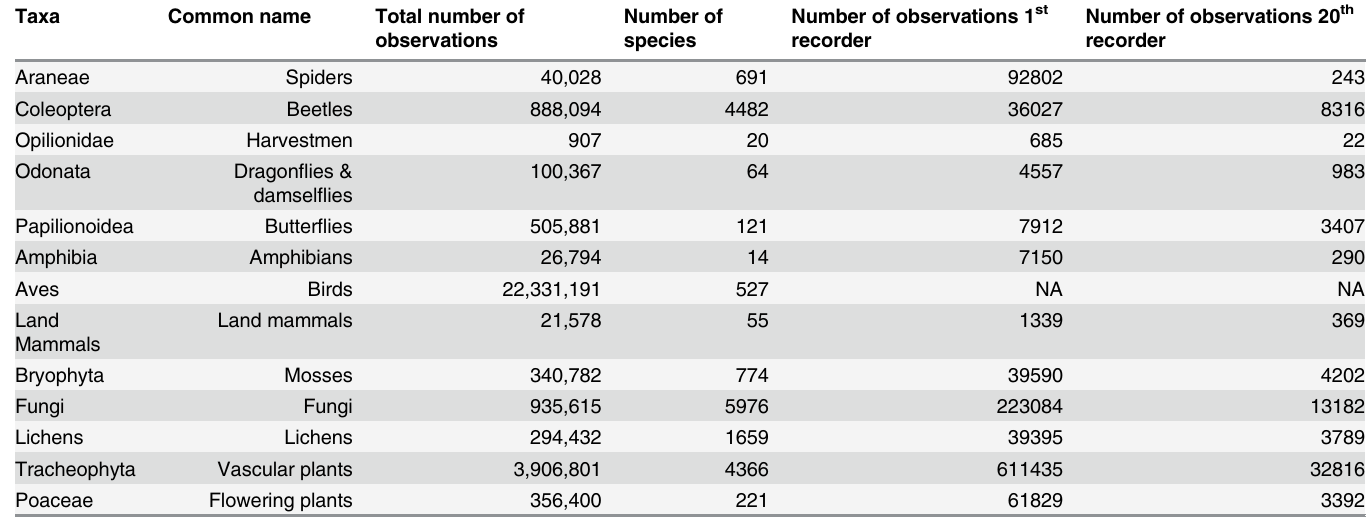
Table 1. The total number of observations across Sweden for each of the 13 taxonomic groups studied for the period 2000 – 14, the number of spe- cies in each taxonomic group, and the number of observations contributed by the 1 st recorder and the 20 th recorder (ranked by number of observa- tions